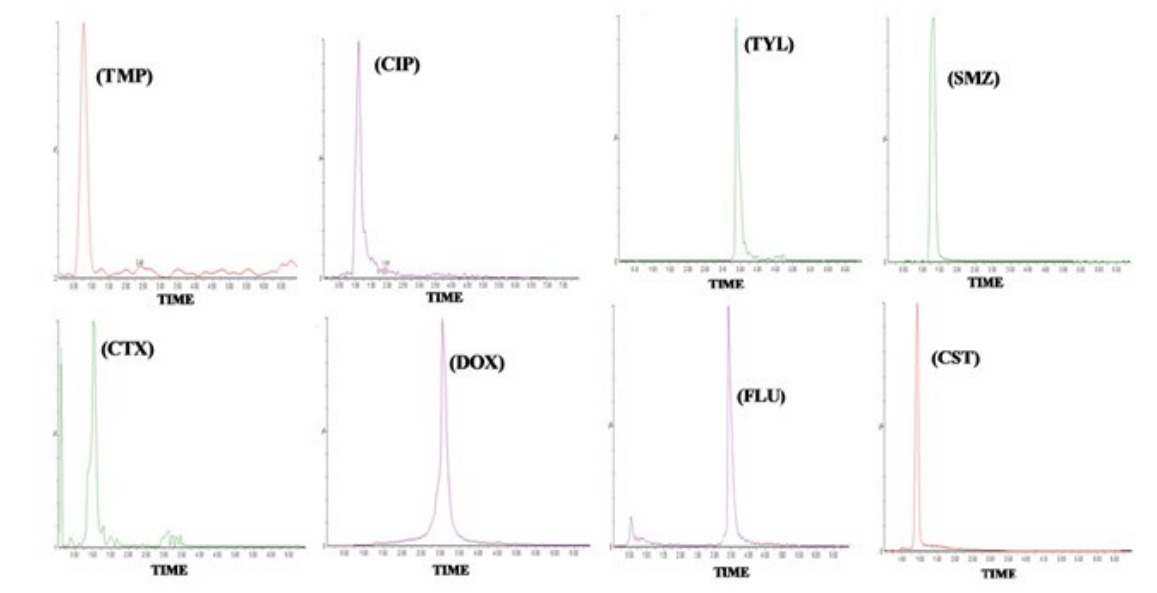
Figure 5. LC/MS/MS chromatogram of TMP, CIP, TYL, SMZ, CTX, DOX, FLU, and CST. Table 5. LC/MS/MS analysis of TMP, CIP, CTX, DOX, TYL, SMZ, FLU, and CST residue in the chicken